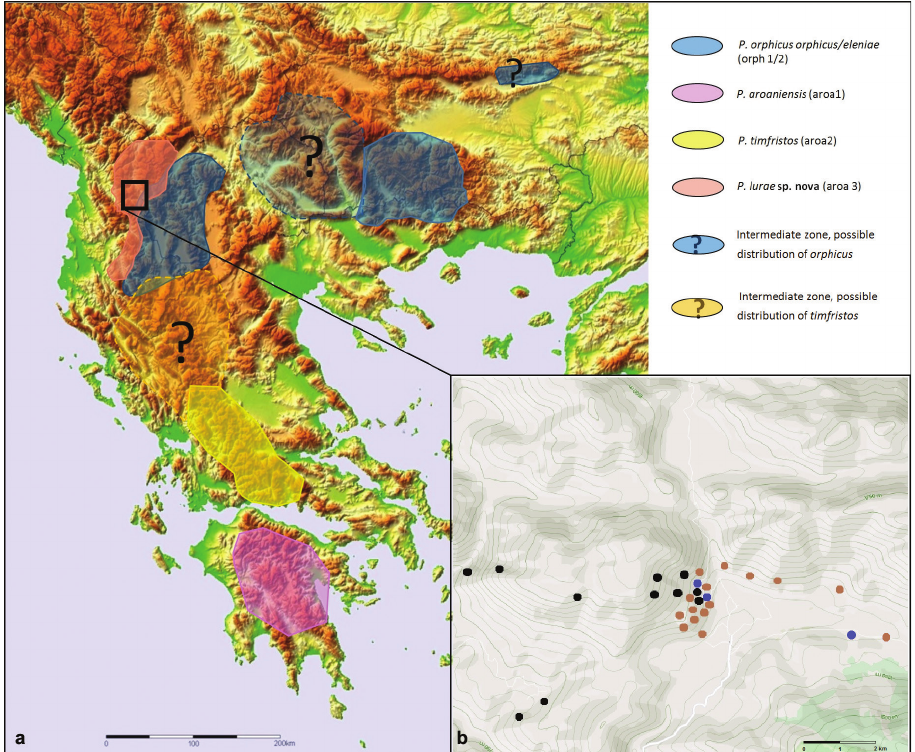
Figure 7. a distribution map based on literature and predictions of the anomalous blues within the P. aroaniensis species complex in the Balkan peninsula; colours correspond to the species in the legend; box is indicating the Lurë region in Albania b detailed map of the Lurë region with observations of P. lurae sp. nov (black dots) on dark ophiolites, P. orphicus (brown dots) and putative hybrids (blue dots) in the contact zone (blue dots) and a dispersive specimen outside suitable biotope (paler blue